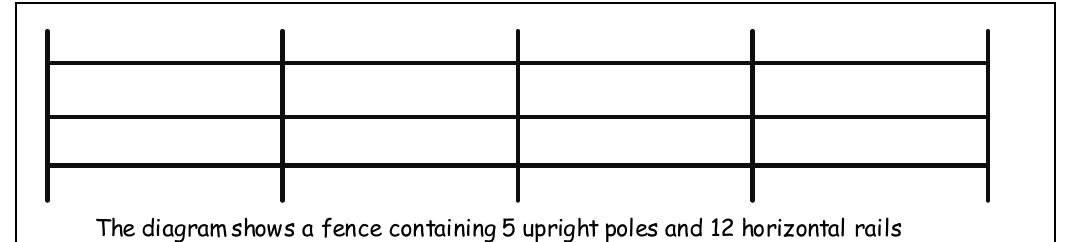
Figure 5. A single pictorial